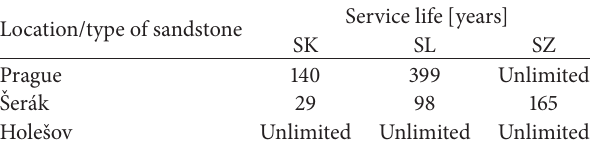
Table 11: Service life estimate of sandstone building